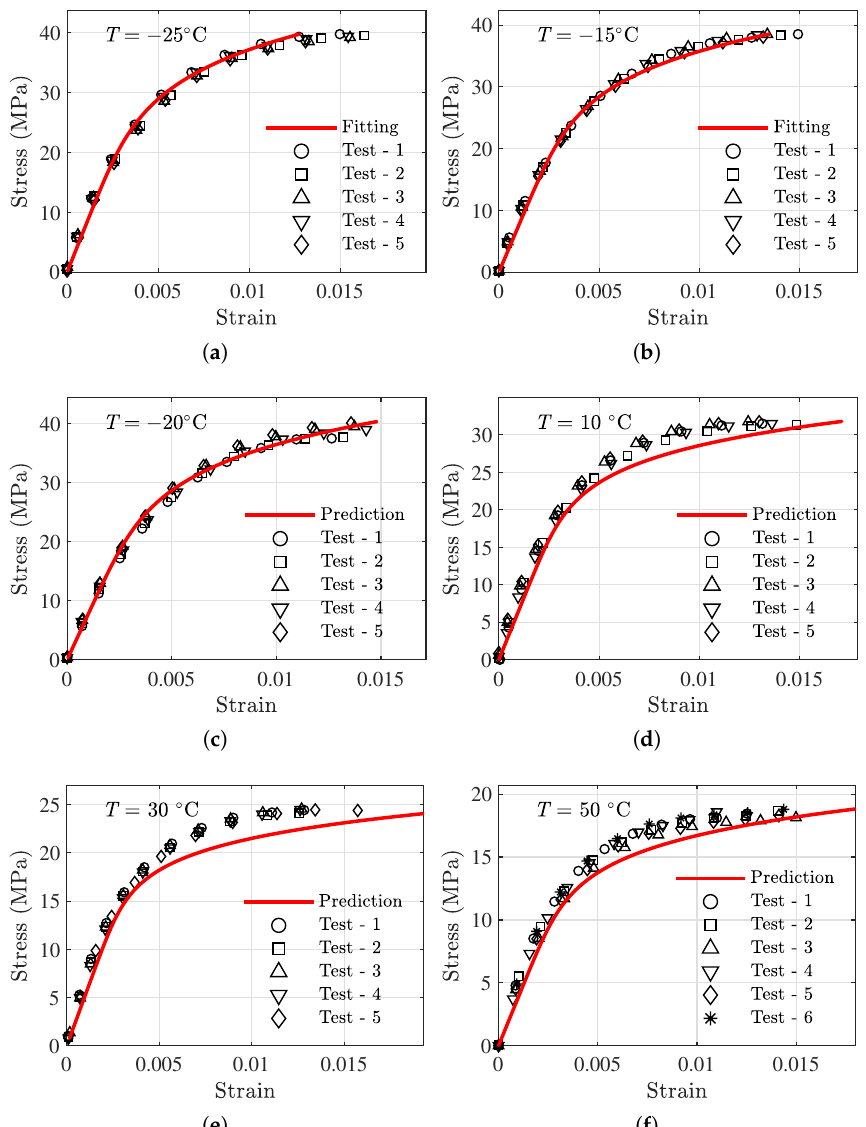
Figure 14. Prediction results of the test data under compression. ( a , b ) modeling data; ( c – f ) valida- tion